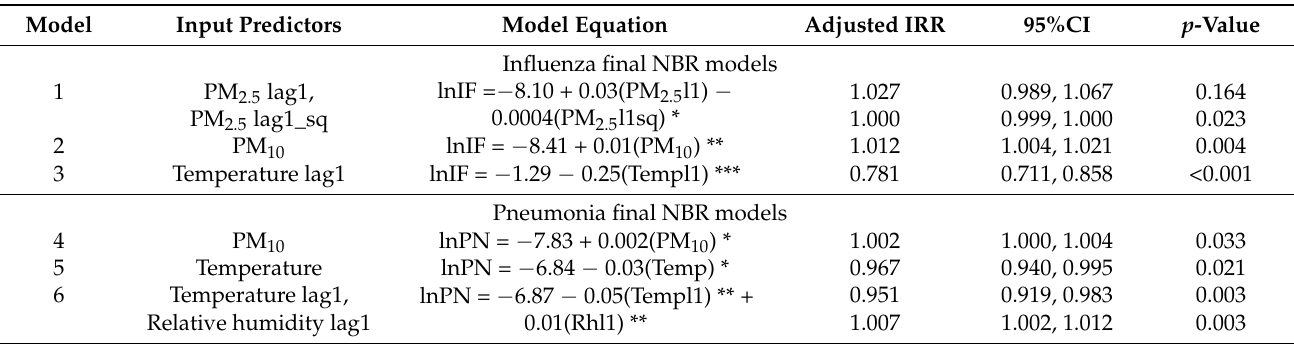
Table 3. Final NBR models with associated environmental risk factors for respiratory disease inci- dences in Chiang Mai from 2011 to